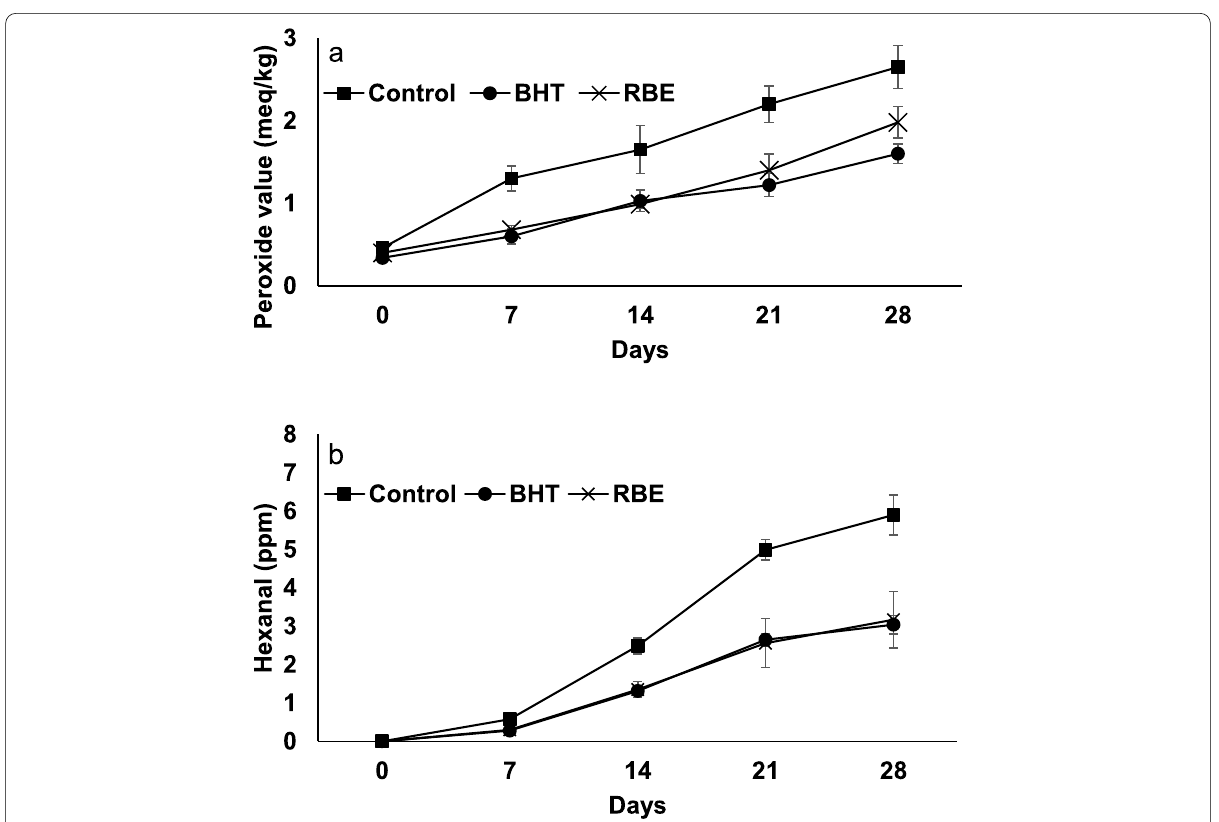
Fig. 3 Effect of RBE and BHT on the formation of peroxides and hexanal in cake samples during storage at room temperature; a peroxide formation of cakes and b hexanal formation in cakes over time. Each data point represents mean